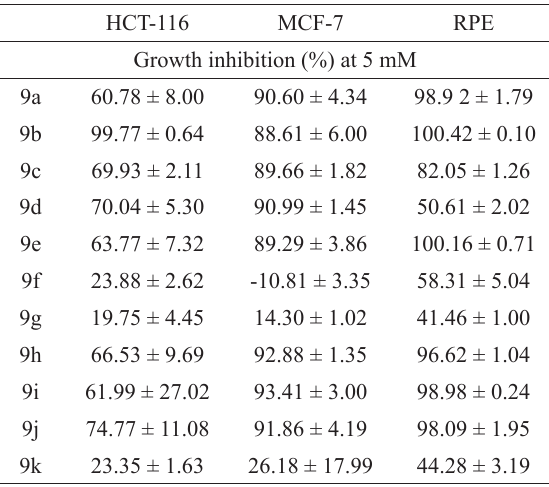
Growth inhibition (%) of 3 cell lines: HCT-116 (colon adenocarcinoma); MCF-7 (breast adenocarcinoma) and RPE (human non-tumor cell line from retinal epithelium) of naphtoquinones after 72 hours of incubation.